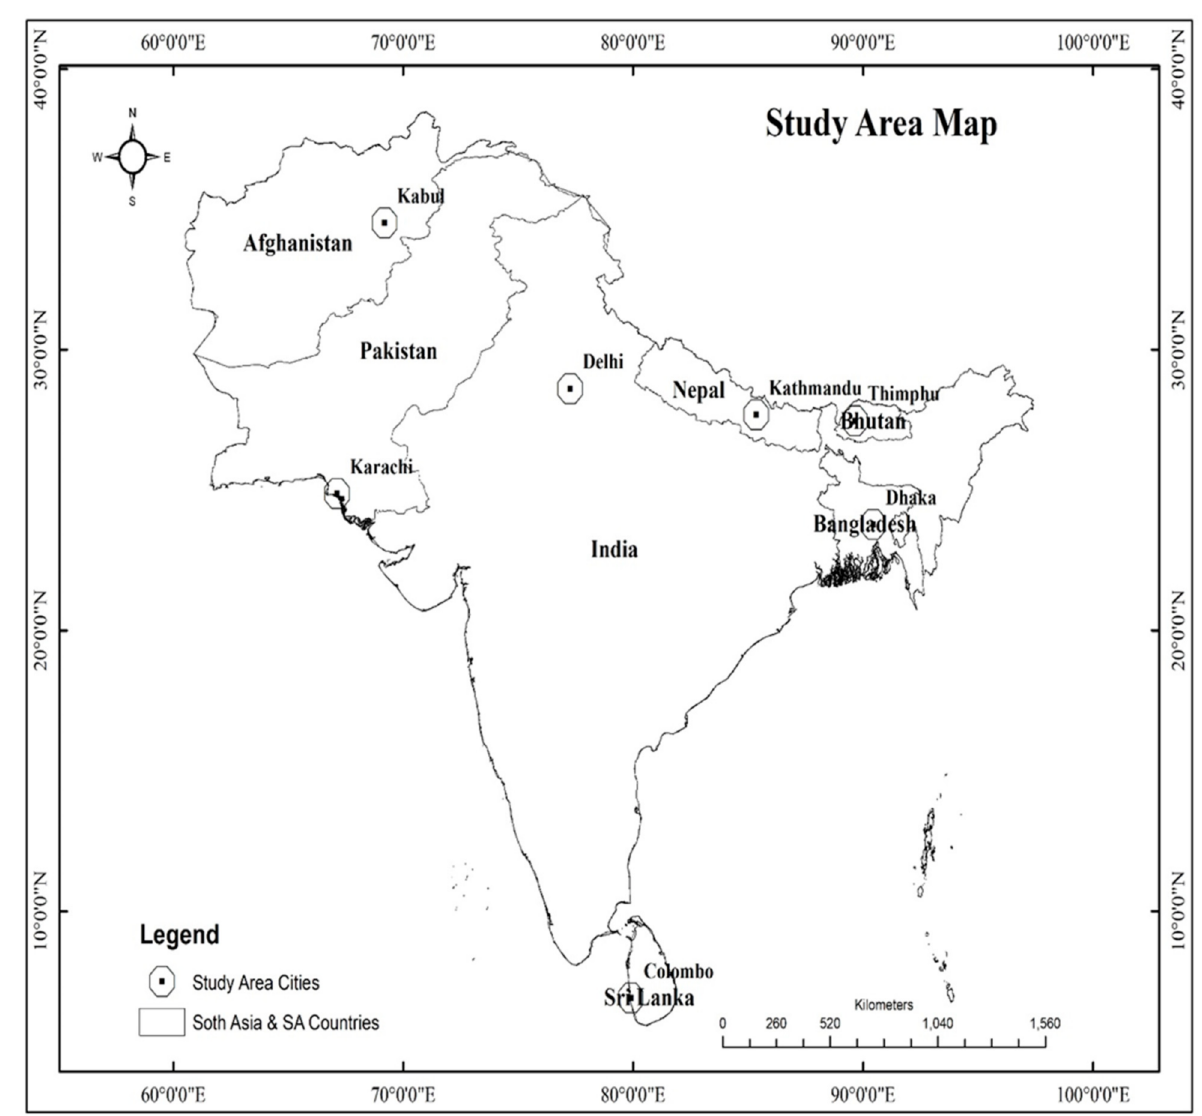
Figure 1. Study area